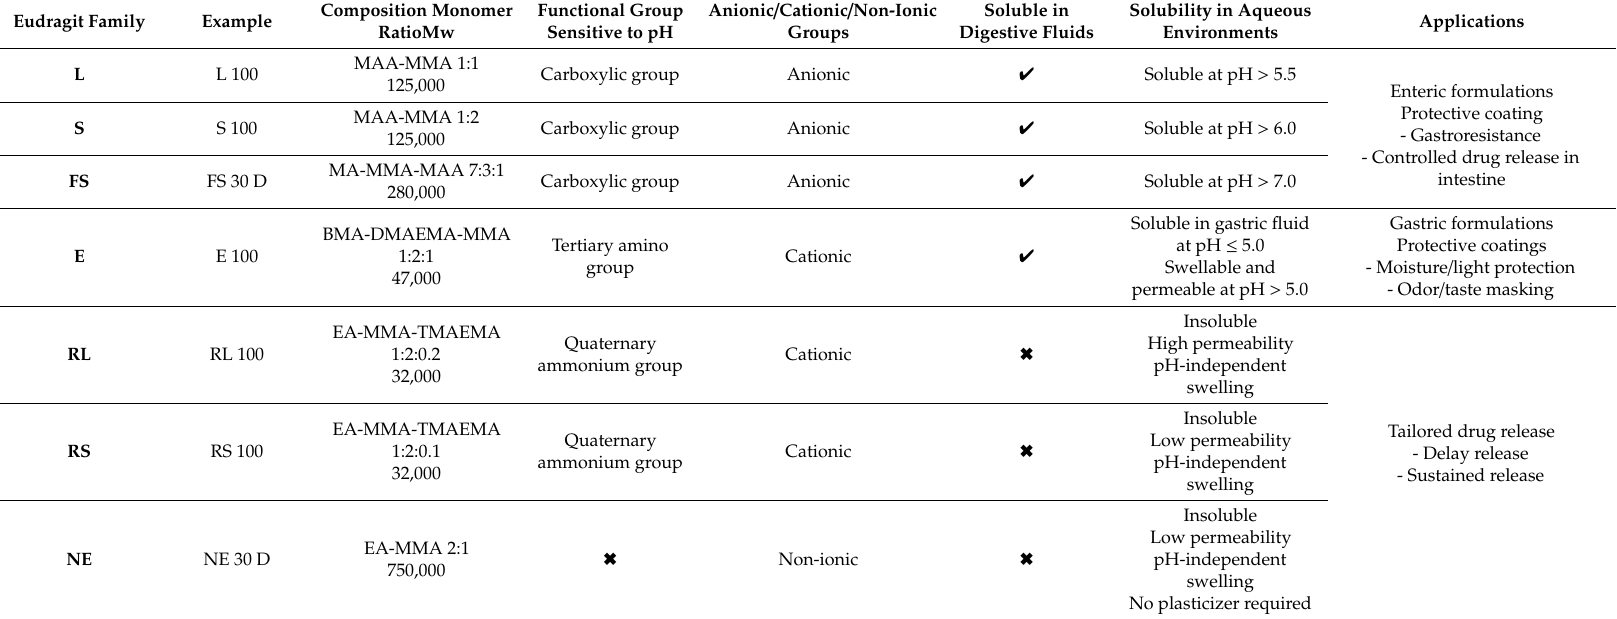
Table 5. Chemical composition and properties of selected Eudragit ® grades